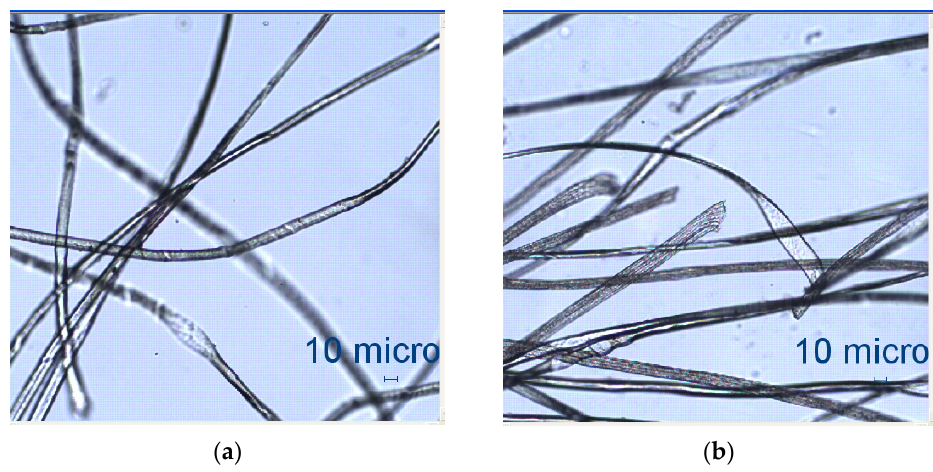
Figure 1. Microscopical view of meta-aramid and para-armid fibers (METAFINE.X.95 ® yarns) and meta-aramid and viscose FR fibers (METALEN ® yarns) (magnification 10×). ( a ) Meta-aramid and para-armid fibers (METAFINE.X.95 ® yarns). ( b ) Meta-aramid and viscose FR fibers (METAFINE.X.95 ® yarns). Table 1. The main characteristics of two-ply twisted yarns with new structures. Code of Pattern Pattern of Knitted Fabric